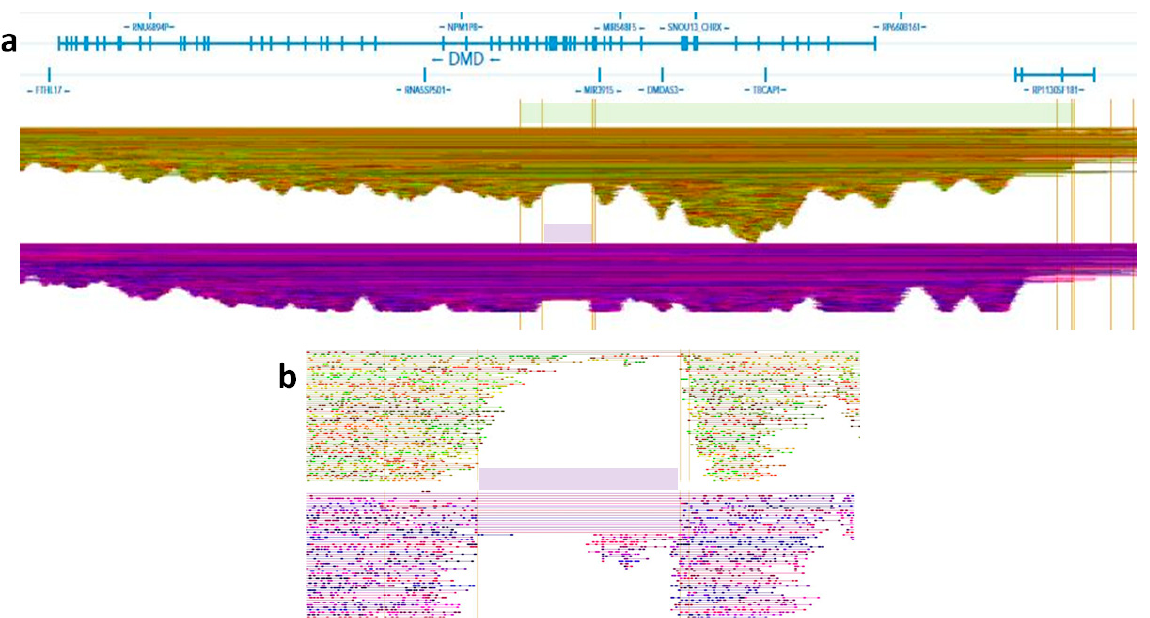
Figure 4. A selection of Linked-Reads in the DMD gene. Each dot corresponds to a single read; reads from the same GEM are horizontally linked with a line. The analyzed genome is displayed as two haplotypes: one placed on the top and the second one on the bottom. Linked-Read panels showing: ( a ) the duplication of DMD exons 1–34 with the 0.5 Mb-long upstream region is highlighted with a light green bar on the top haplotype, in which there are more phased reads; the deletion of DMD exons 16–29 is highlighted with a light purple bar on the bottom haplotype. The breakpoint-containing region is magnified in panel ( b ).